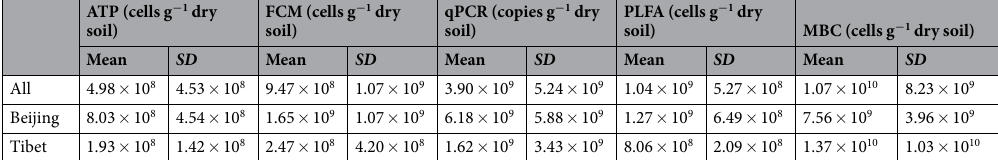
Table 1. Absolute quantification of microbial biomass in the soil samples determined by different